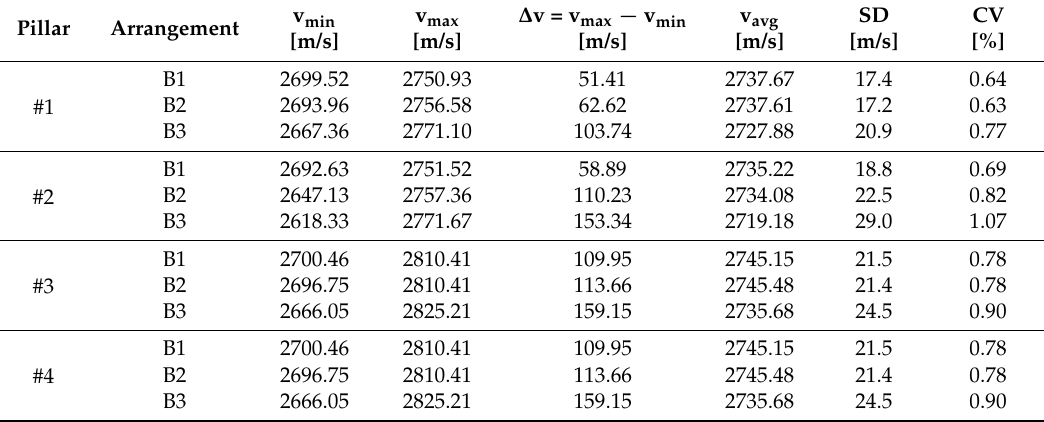
Table 3. Numerical wave propagation velocities for configuration